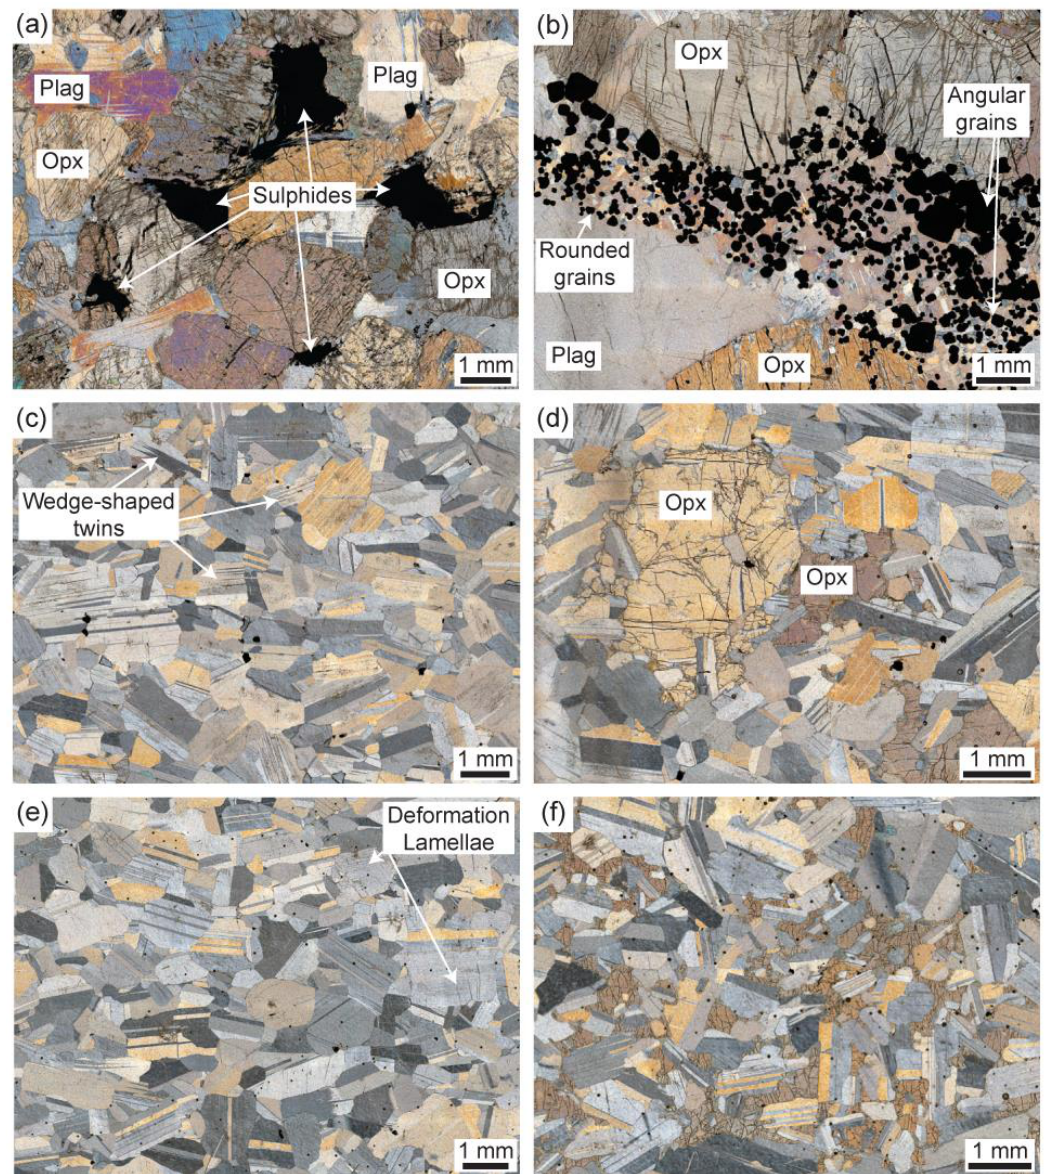
Figure 7. Photomicrographs from the Merensky Unit, photographed under differential interference contrast (DIC) as an approximation of circularly polarised light (CPL); all photographs are the correct way up: ( a ) Interstitial sulphides in feldspathic orthopyroxenite; ( b ) Upper chromitite with mix of rounded and angular Cr-spinel grains; ( c ) HW 1 leuconorite Plag groundmass; ( d ) HW 1 leuconorite with oikocrystic Opx grains; ( e ) HW 2 poikilitic anorthosite Plag groundmass; ( f ) HW 2 poikilitic anorthosite with tabular plagioclase grains hosted in a single Opx oikocryst; Abbreviations: Opx = orthopyroxene; Cpx = clinopyroxene; Chr = Cr-spinel; Plag = plagioclase.